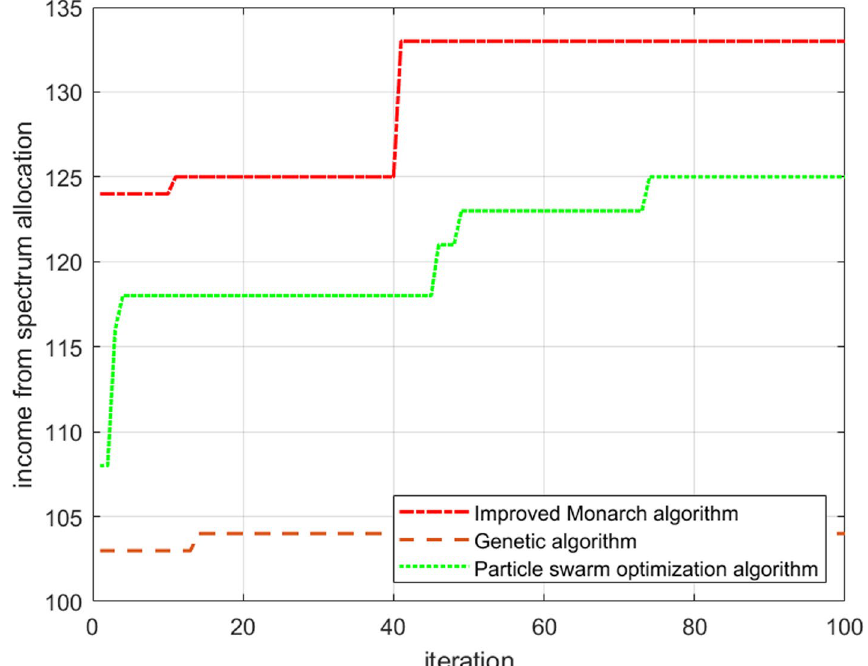
Fig. 7 Spectrum allocation income changes of the improved monarch butterfly algorithm, genetic algorithm and particle swarm optimization algorithm when T =